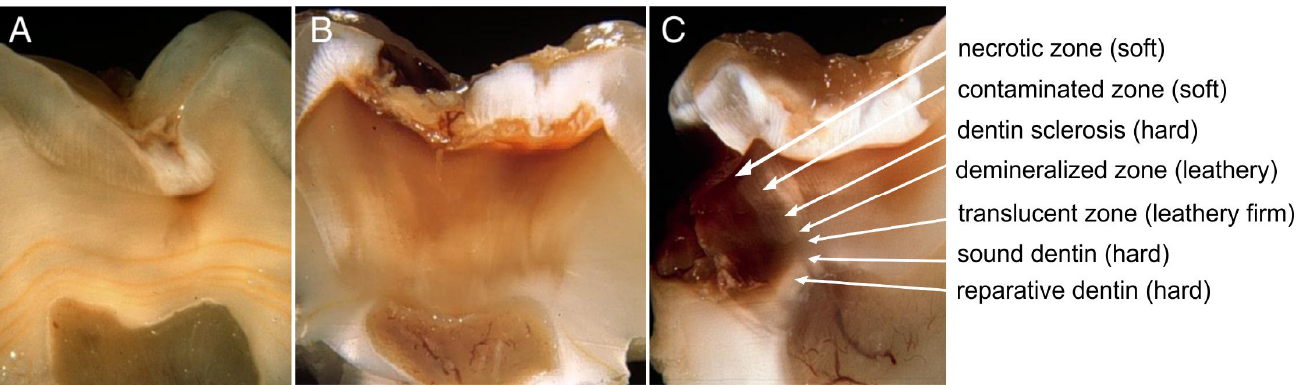
Figure 1. Progress of caries ( A , B ); reactions and different zones of dentin caries ( C ); reprinted with permission from Bjørndal et al. published by Elsevier 2014 [29] .